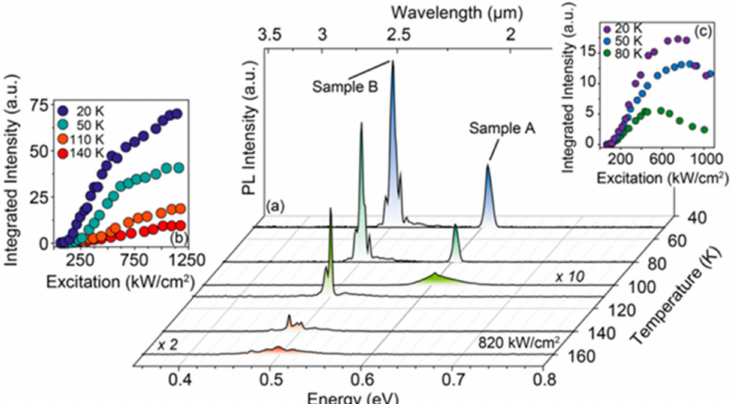
Figure 30. ( a ) Temperature-dependent lasing spectra for samples A and B (the Sn contents for samples A and B were 8.5% and 12.5%, respectively); ( b , c ) L–L curves for samples A and B, respectively. Reproduced with permission from [74], American Chemical Society,